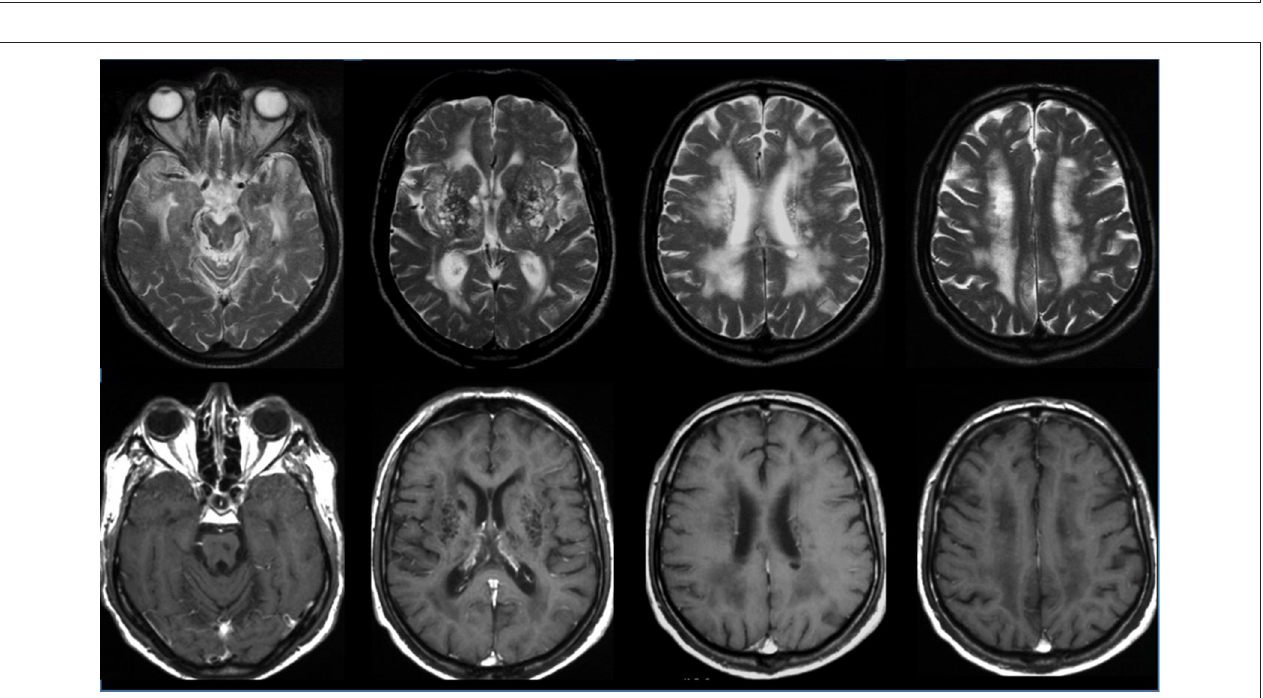
FIGURE 3 | Neuroimaging of cerebrovascular disease in the aging brain. The figure shows a brain MRI study of a patient with risk factors affected by cognitive disorders. The images above (T2-weighted axial slices) and below (T1-weighted axial slices, after contrast enhancement) show diffuse, punctate deep white matter foci, hyperintense T2-weighted images, with a low signal intensity on T1-weighted images and without contrast enhancement, suggesting cerebral small vessel vascular disease. that a considerable effort has been made in recent years to diagnosis of probable AD has a sensitivity and specificity of assess the analytical and clinical validity of biomarkers related only 70.9 and 70.8%, respectively, when compared with the to neurodegeneration, such as neuroimaging and CSF, so as to “gold standard” pathological findings (67). It is for this reason